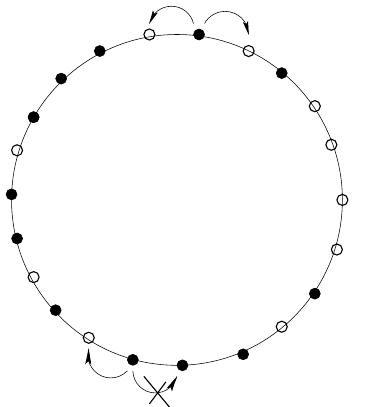
Fig. 1. Ring consisting of N sites, with (cid:1) N agents placed on the blackened sites and the white circles are